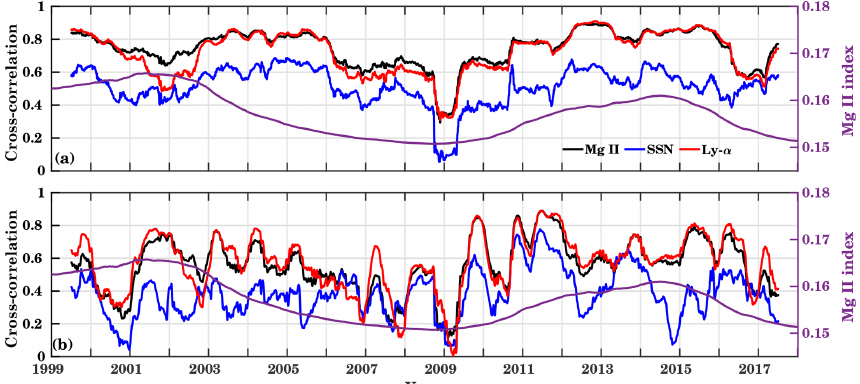
Figure 7. Running cross-correlations between GTEC and different solar proxies for (a) short (27d residual), and (b) intra-annual timescales (original time series). For the short timescale the 27d residuals have been calculated by removing the 27d running mean from the original datasets. A 365d running window is used to calculate the correlation. The second y axis shows 365d ( a and b ) running mean time series of Mg II index. Here Mg II, SSN, and Ly- α are marked by black, blue, and red colors, respectively.